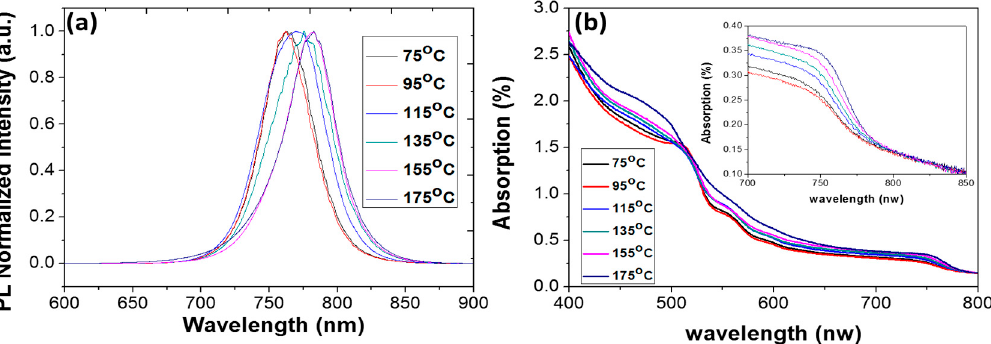
Figure 5. ( a ) PL and ( b ) absorbance spectra of perovskite films annealed at various temperatures.